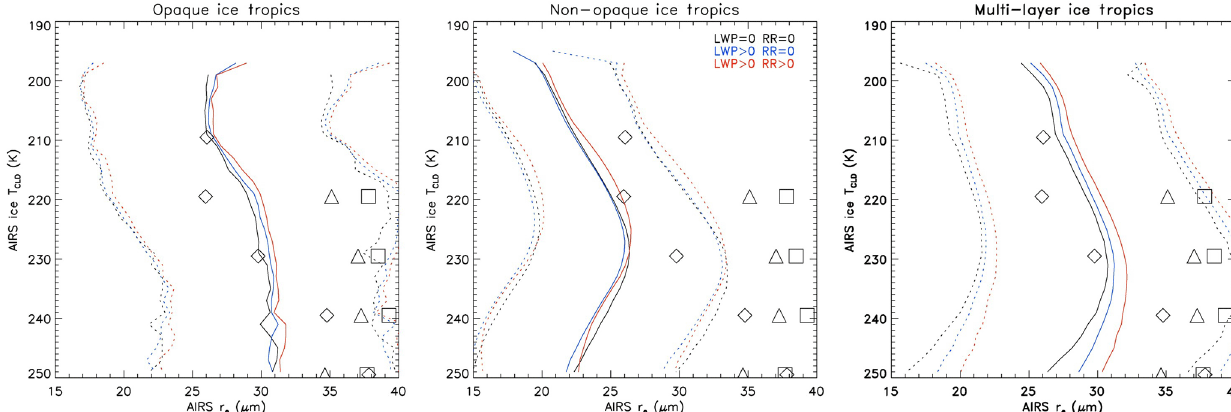
Figure 7. The mean (solid) and ± 1 σ values of AIRS IR only r ei vs. T ci for opaque, non-opaque and multi-layer ice clouds over the tropical oceans during the months of July and August within the 14-year time period of investigation. Refer to Table 3 for definitions of the three categories. The AMSR-E/AMSR-2 estimates of LWP and RR are used to divide categories into clear (LWP = 0) and no rain (RR = 0), according to the passive microwave; cloudy (LWP>0) and no rain (RR = 0); and cloudy (LWP>0) and rain (RR>0). The results in both panels have all AIRS ice clouds filtered within 6K of the cold point tropopause; otherwise a much larger and potentially unphysical increase in r ei would be observed in the figures at the coldest temperatures. The symbols are average r ei from in situ field campaign data for the CRYSTAL-FACE (diamonds), TC4 (triangles), and NAMMA (squares) campaigns; please see Heymsfield et al. (2014) for more